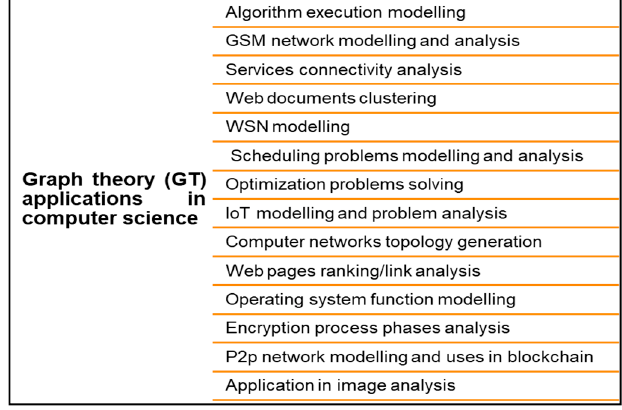
Figure 1. Graph theory applications in the computer science field.